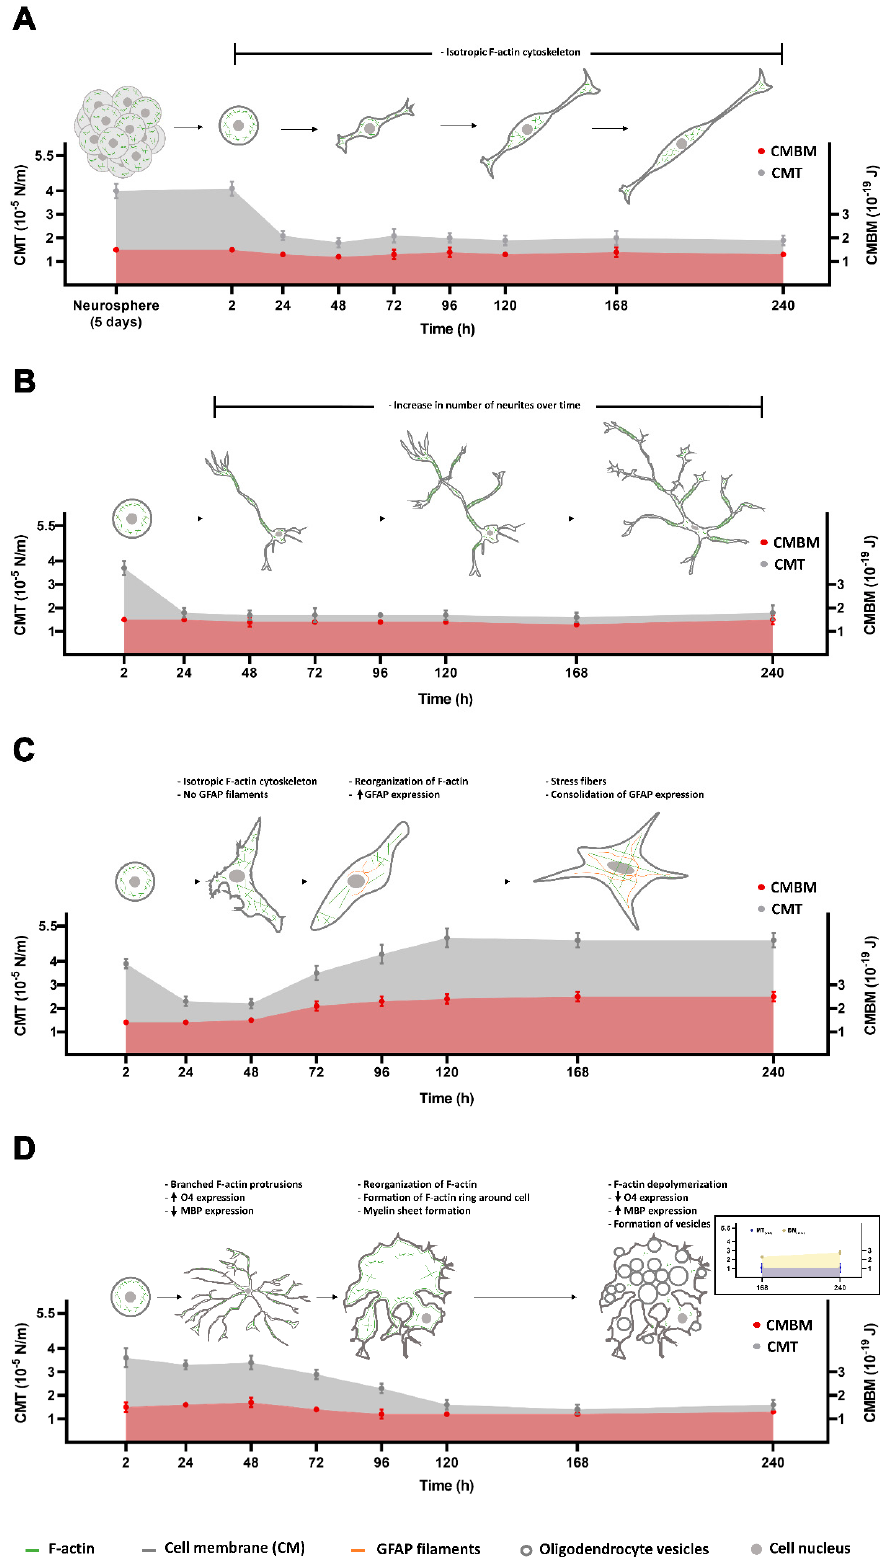
Figure 7. Schematic representation correlating the variations in morphological phenotype with CMT and CMBM for ( A ) undi ff erentiated NPCs, ( B ) NPCs plated in Neurobasal medium, ( C ) NPCs induced to di ff erentiate into astrocytes and ( D ) NPCs induced to di ff erentiate into oligodendrocytes. Insert in D represents the membrane tension and bending modulus for vesicles that appear at the surface of oligodendrocyte